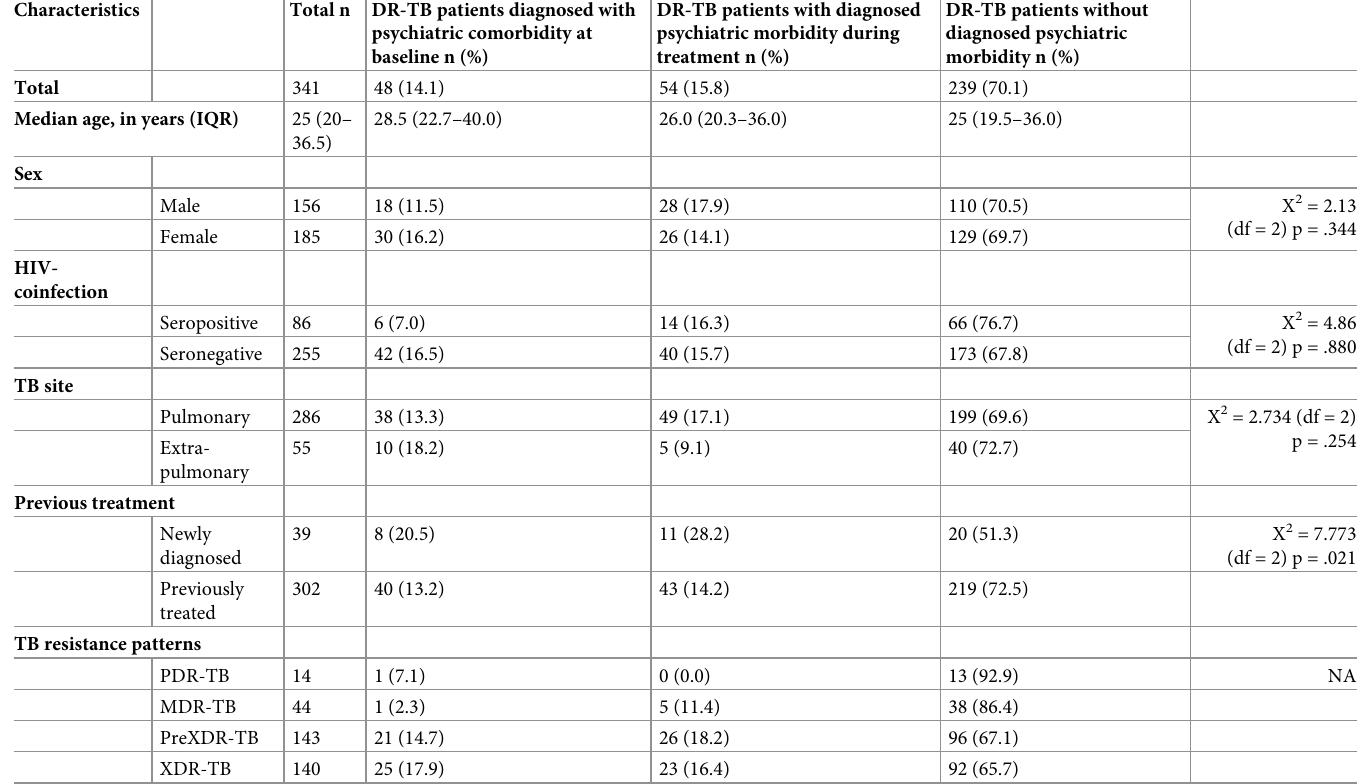
Table 1. Demographic and clinical characteristics of drug-resistant tuberculosis patients initiated on treatment at the Me´decins Sans Fronti è res Mumbai clinic between January 2012 and March 2019. Characteristics